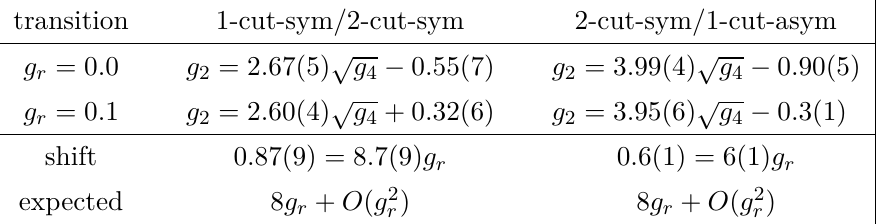
Table 1 . The full model (2.8) transition line fits for N = 24 and g 4 ≥ 1 .